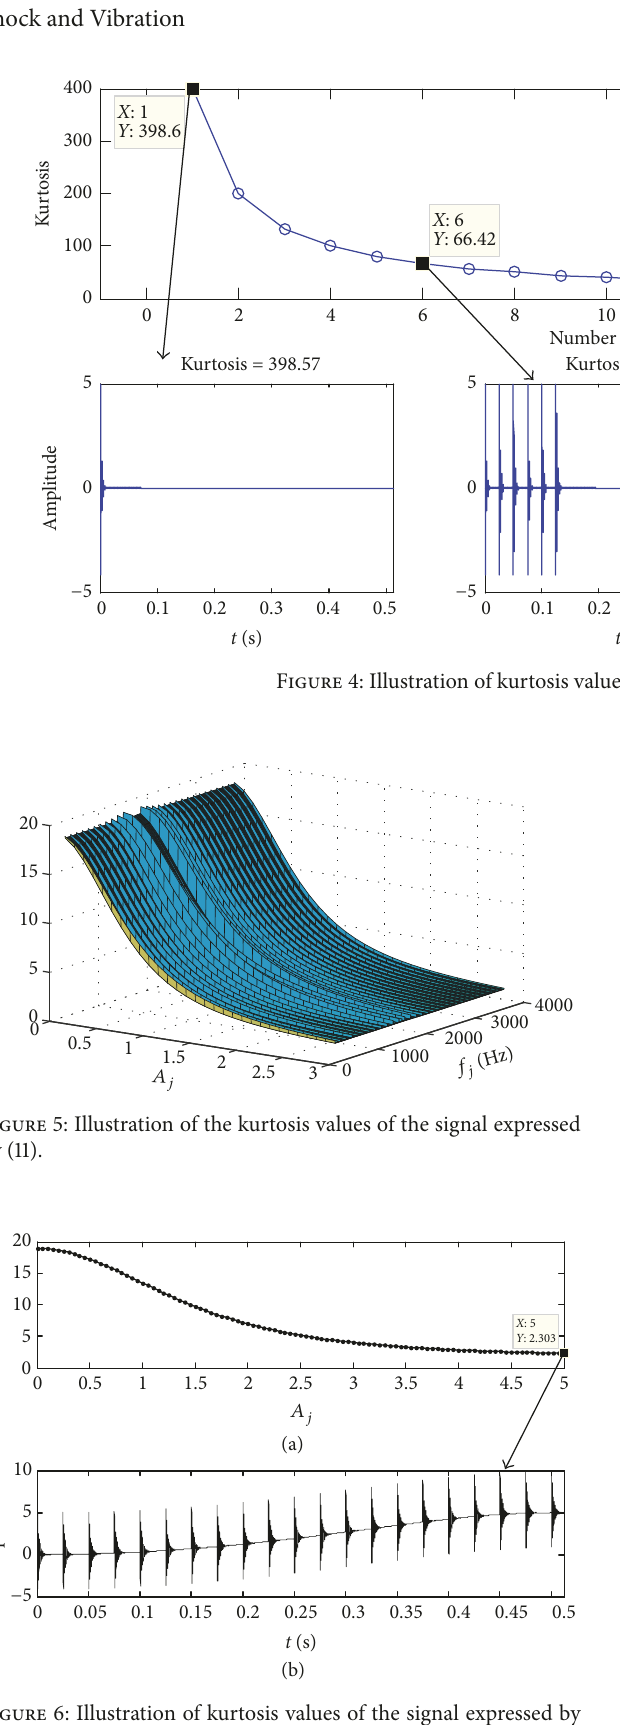
Figure 6: Illustration of kurtosis values of the signal expressed by (12). (a) The kurtosis value varying with 𝐴 𝑗 . (b) A signal waveform.